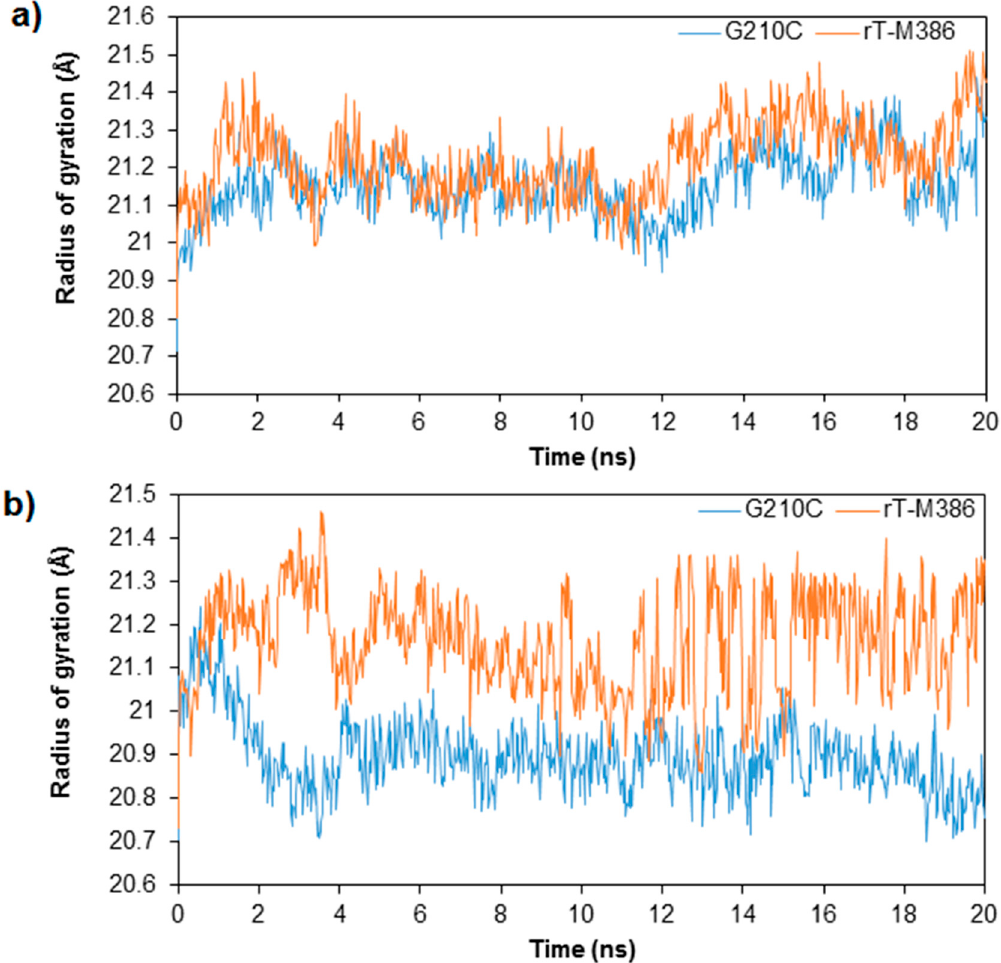
Figure 6. Radius of Gyration of the rT-M386 and G210C lipases as per time. ( a ) at 25 °C ( b ) at 50 °C. The simulation was analyzed over 20 ns trajectories. The radius of gyration of rT-M386 and G210C lipases are indicated by red and blue lines, respectively.